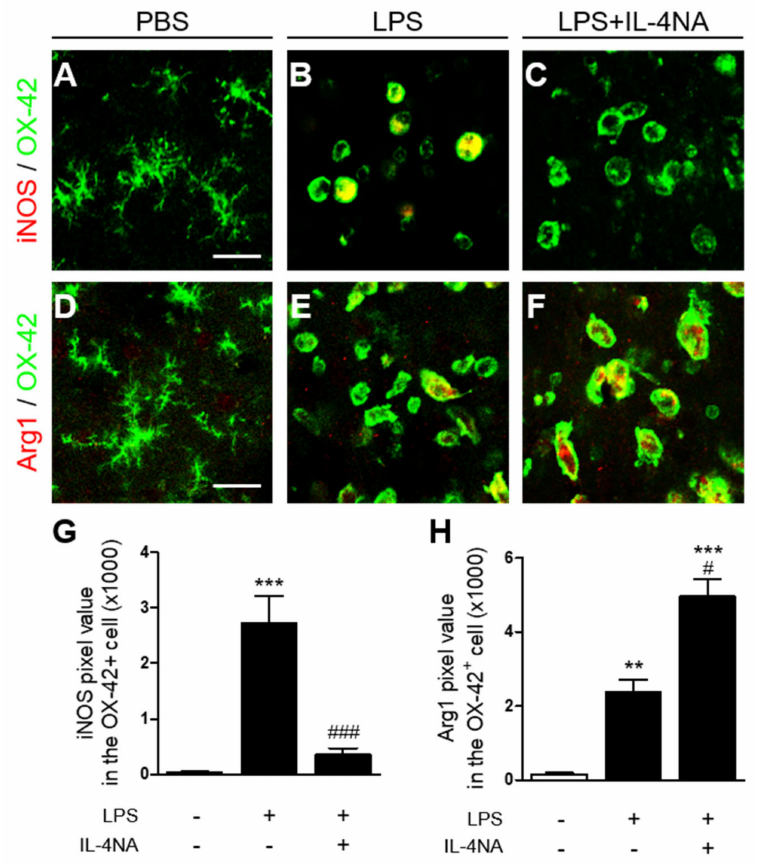
Figure 6. IL-4 modulates M1/M2 activation state of microglia/macrophages in LPS-injected striatum in vivo. Sections adjacent to those used in Figure 4 were prepared for immunohistochemical staining. ( A – C ) Immunofluorescence images of iNOS (inducible nitric oxide synthase, red) to identify classical activation of microglia/macrophages (M1 state) and OX-42 (green), and both images were merged (yellow) in striatum treated with PBS ( A ), LPS ( B ), and LPS and IL-4 NA ( C ). Scale bar, 25 µ m. ( D – F ) Immunofluorescence images of Arg1 (arginase 1, red) to identify alternative activation of microglia/macrophages (M2 state) and OX-42 (green), and both images were merged (yellow) in striatum treated with PBS ( D ), LPS ( E ), and LPS and IL-4 NA ( F ). Scale bar, 25 µ m. ( G ) Quantification of iNOS expression in OX-42 + cells. ** p < 0.01, *** p < 0.001, significantly different from PBS. ### p < 0.001, significantly different from LPS. Mean ± SEM; n of animals = 4 to 5 in each group. ANOVA and Bonferroni analysis. ( H ) Quantification of Arg1 expression in OX-42 + cells. ** p < 0.01, *** p < 0.001 significantly different from PBS. # p < 0.05, significantly different from LPS. Mean ± SEM; n of animals = 4 in each group. ANOVA and Bonferroni